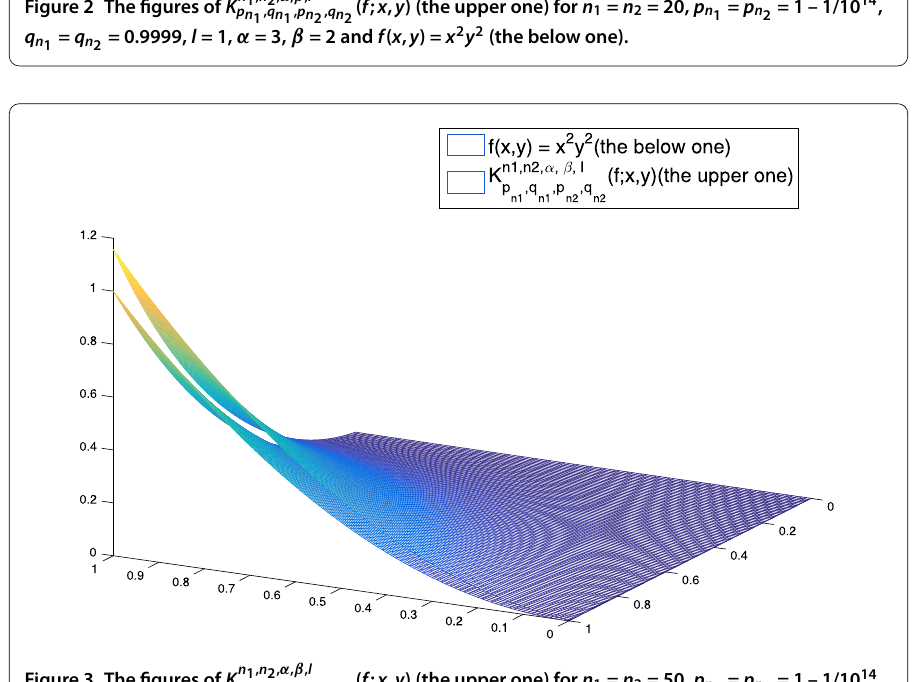
Figure 3 The figures of K n 1, n 2, α , β , l pn 1, qn 1, pn 2, qn